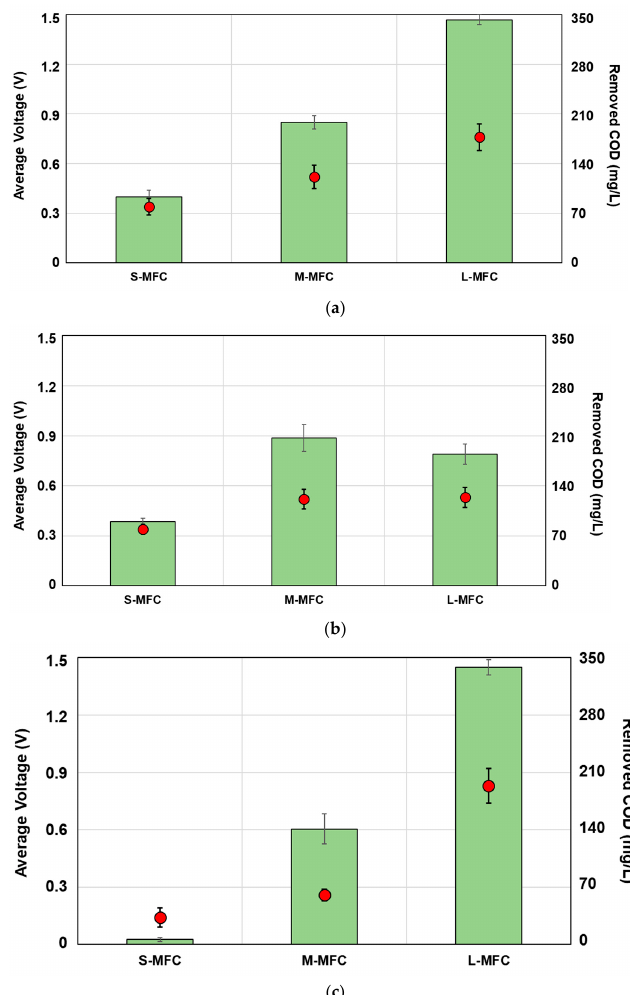
Figure 4. Removed chemical oxygen demand (COD) (green bar) and average voltage (red circle) of S-, M-, and L-MFCs at phase I ( a ), II ( b ), and III ( c ).